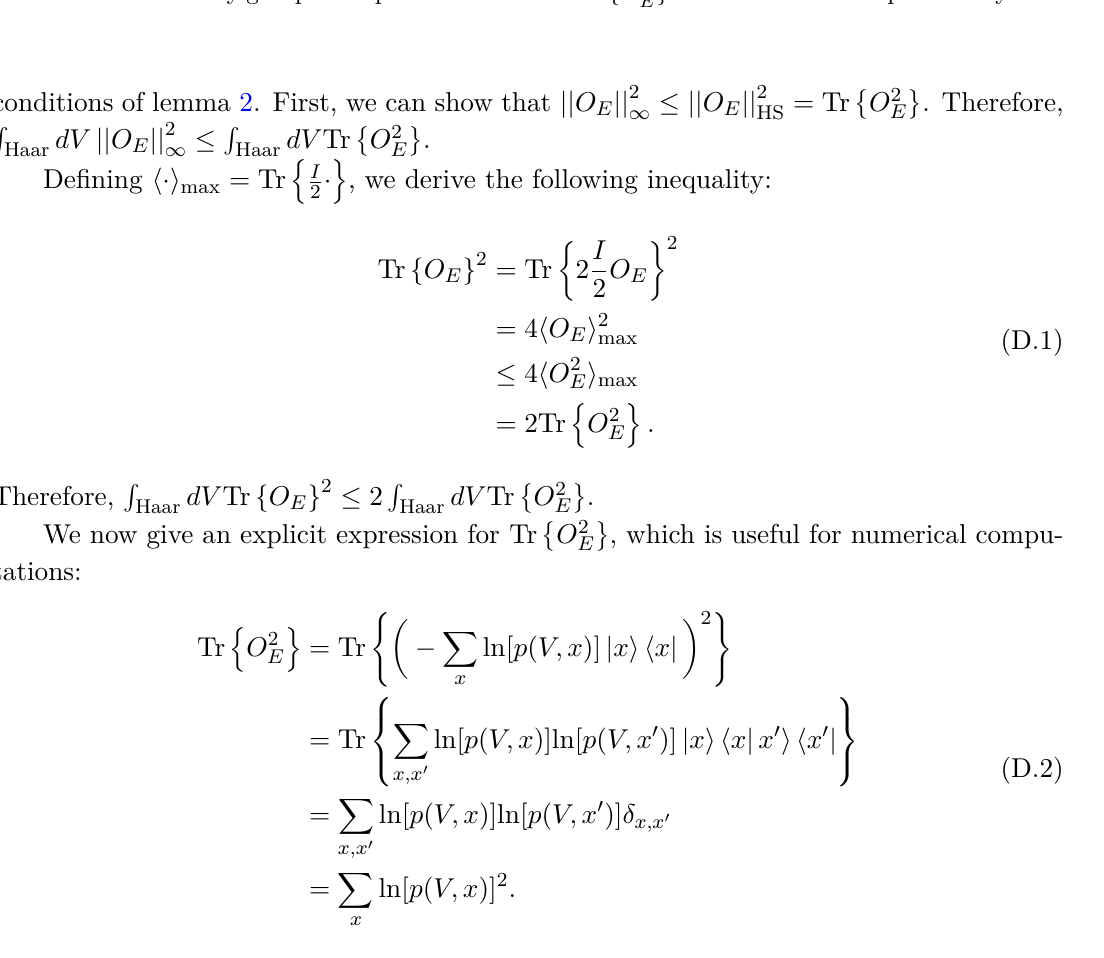
Figure 3 . Plot of Tr { O 2 is empirically computed by averaging Tr measure on the unitary group. The plot indicates that Tr { O 2